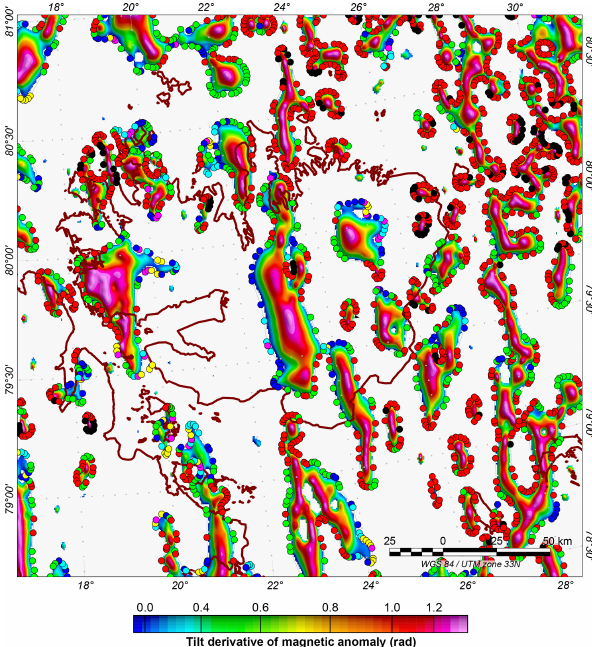
Figure 6. The tilt derivative of the magnetic anomaly superimposed by Blakely depth estimation is used to determine the location and depth of geological bodies and to constrain the model. Negative data are nulled. Sill bodies located in northeast Austfonna, both onshore and offshore, are generally shallower than the large and deep N–S- trending granitic intrusions crossing